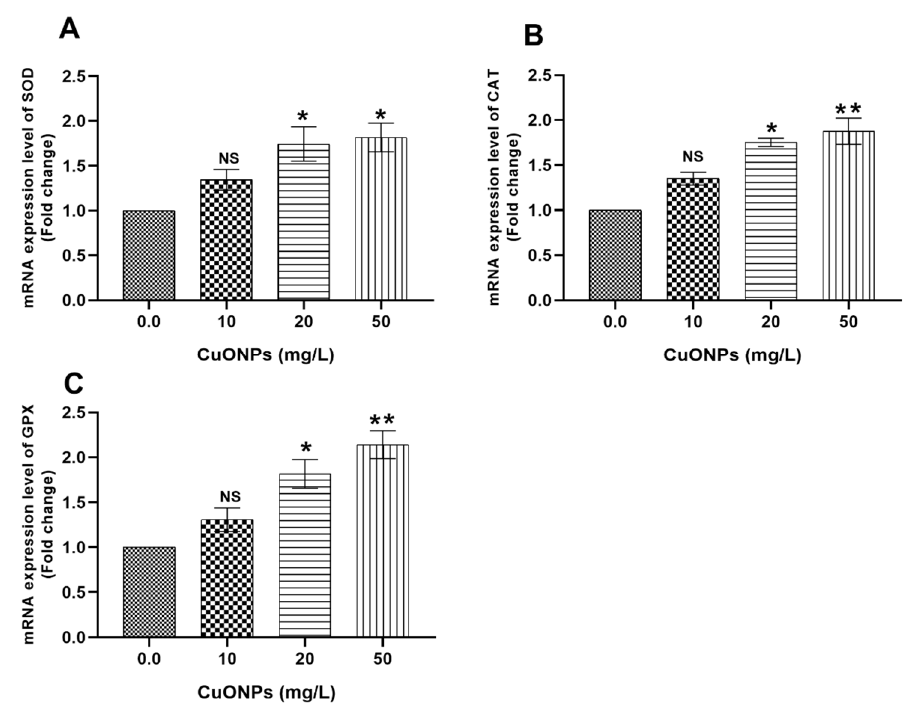
Figure 6. mRNA transcription profile of oxidative stress-related genes ( A ) SOD, ( B ) CAT, and ( C ) GPX in the hepatic tissues of Nile tilapia juveniles after exposure to sub-lethal concentrations of CuONPs (0.0 mg/L, 10 mg/L, 20 mg/L and 50 mg/L) for 25 days. The values are expressed as mean ± SEM ( n = 9). Asterisk (*) ( p < 0.05), and (**) ( p < 0.01) indicate significant differences between the exposure groups compared with the control group. NS indicates non-significant differences.